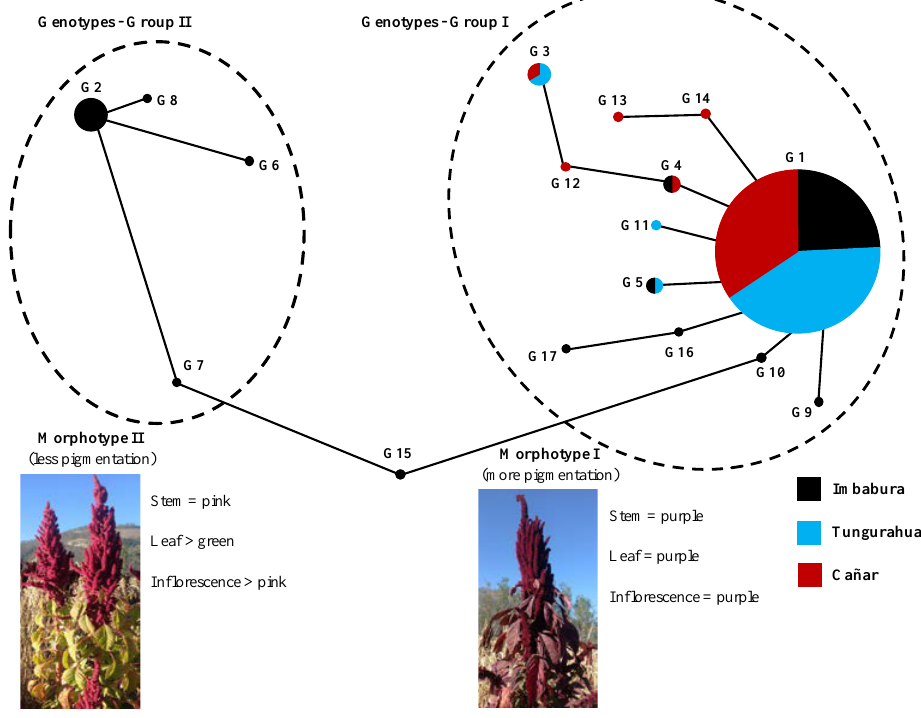
Figure 4. Minimum spanning tree (MST) showing the genetic relationships of 17 genotypes (G1 to G17) found in 139 black amaranth accessions. The circle sizes are proportional to the abundance of each genotype (see Table 4), and the colors indicate the province to which the samples that present them belong. The association of the two groups of Genotypes (I and II, circles with dashed lines) with the two color Morphotypes (I and II; see Delgado et al. [32]) differentiated in the morpholog- ical characterization is indicated.